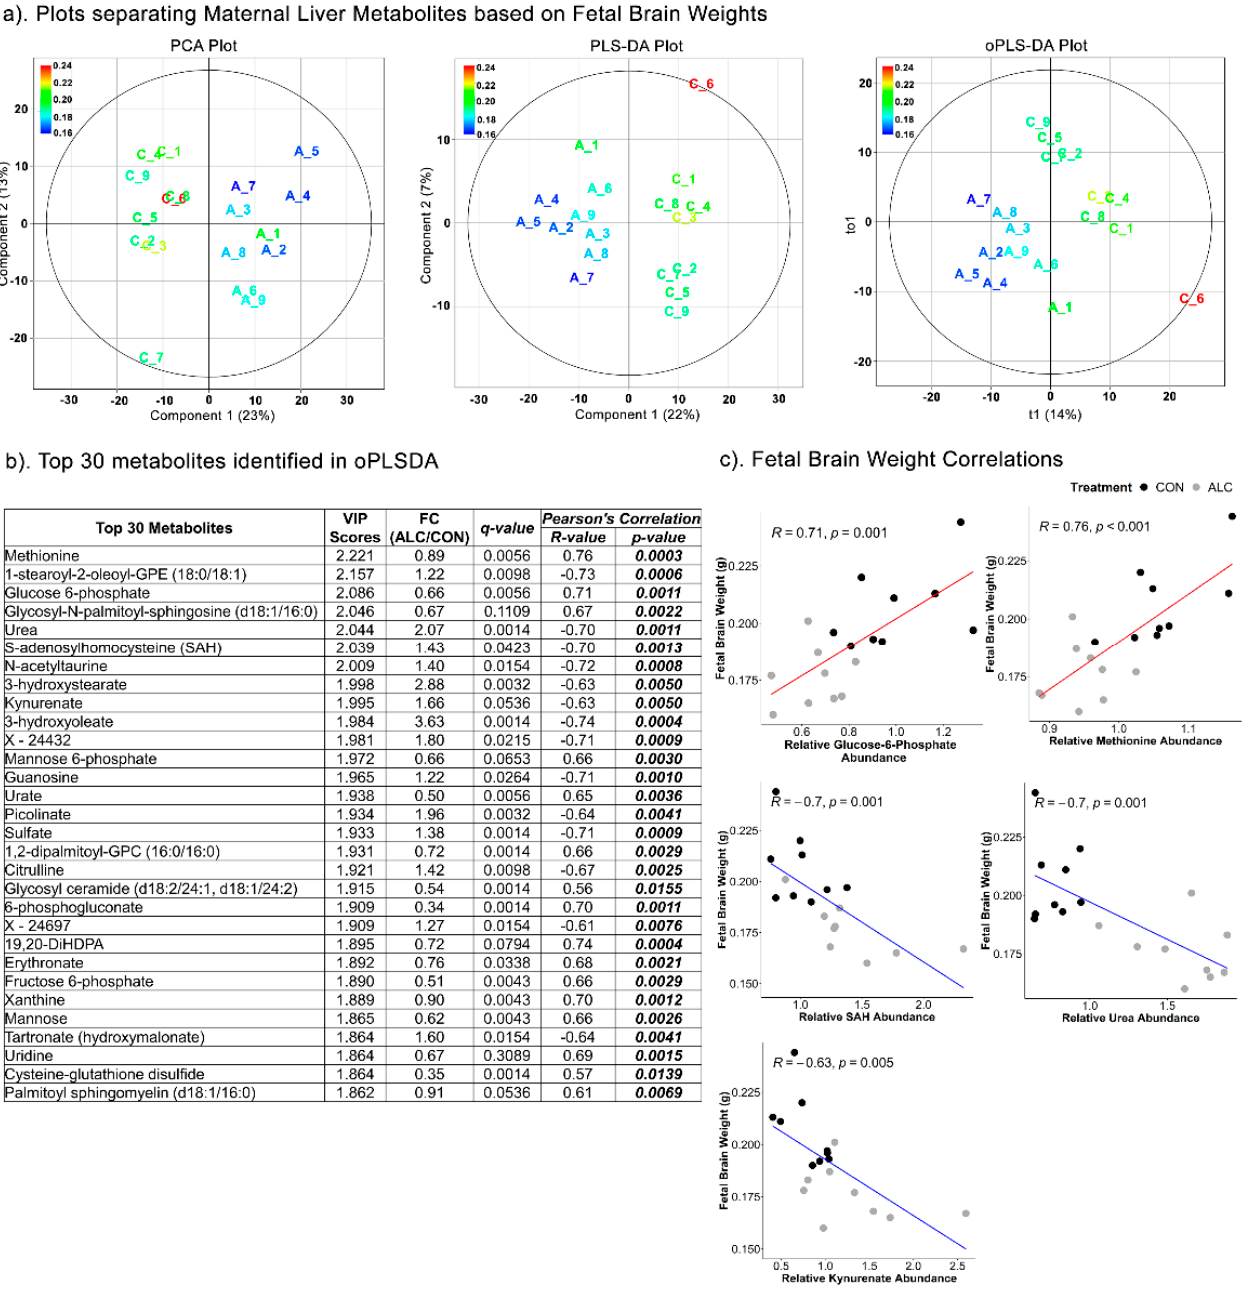
Figure 6. Separation of maternal liver metabolites as ALC vs. CON based on fetal brain weights. ( a ) PCA, PLS-DA, and oPLSDA plots depicting the separation of maternal liver metabolites as ALC vs. CON based on fetal brain weights. The legend and the corresponding color in the plots indicate increase in fetal brain weights (in g) values from blue to red. ( b ) The top 30 metabolites extracted as VIP scores in the first orthogonal component in oPLSDA with FC (ALC/CON), q-value, and Pearson’s correlation (R) analysis with respect to fetal brain weights. Significant correlations at p ≤ 0.05 are bold and italicized. ( c ) Correlation plots of top select metabolites identified in oPLSDA with fetal brain weights. The blue and red trendlines indicate significant negative and positive correlations, respectively.